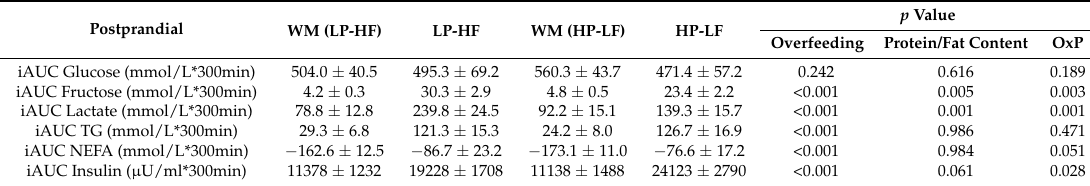
Table 3. Metabolites and hormones at postprandial states.